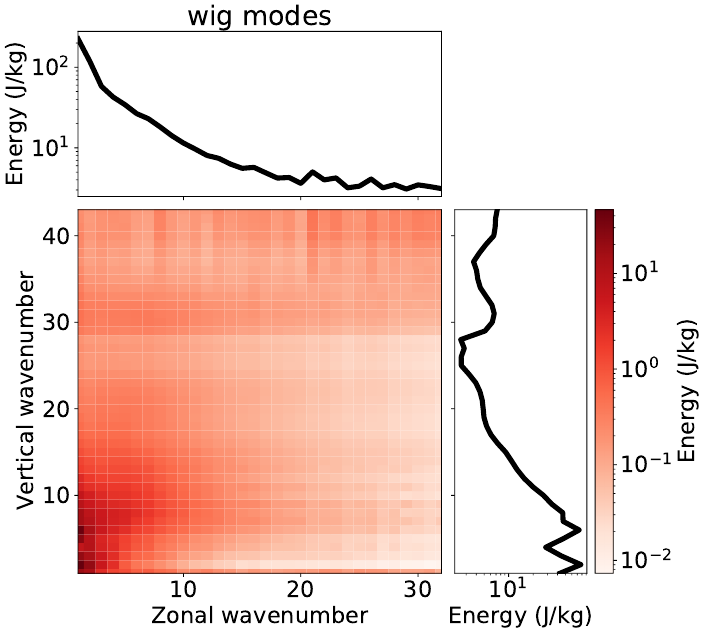
Figure 10. Energy spectrum of the westward inertio-gravity mode component of the atmospheric oscillations as a function of the zonal wavenumber and vertical